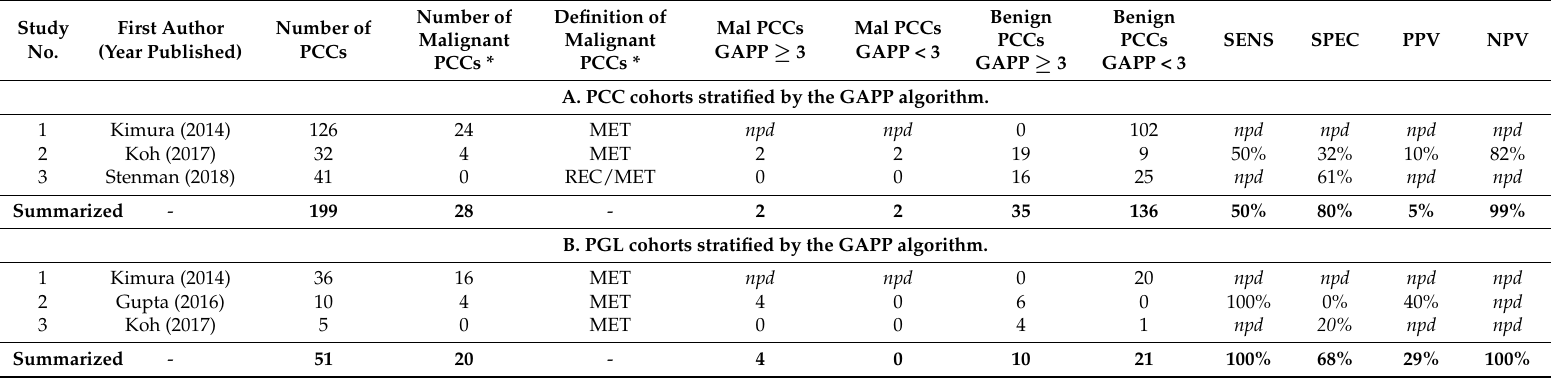
Table 3. PPGL cohorts stratified by the GAPP